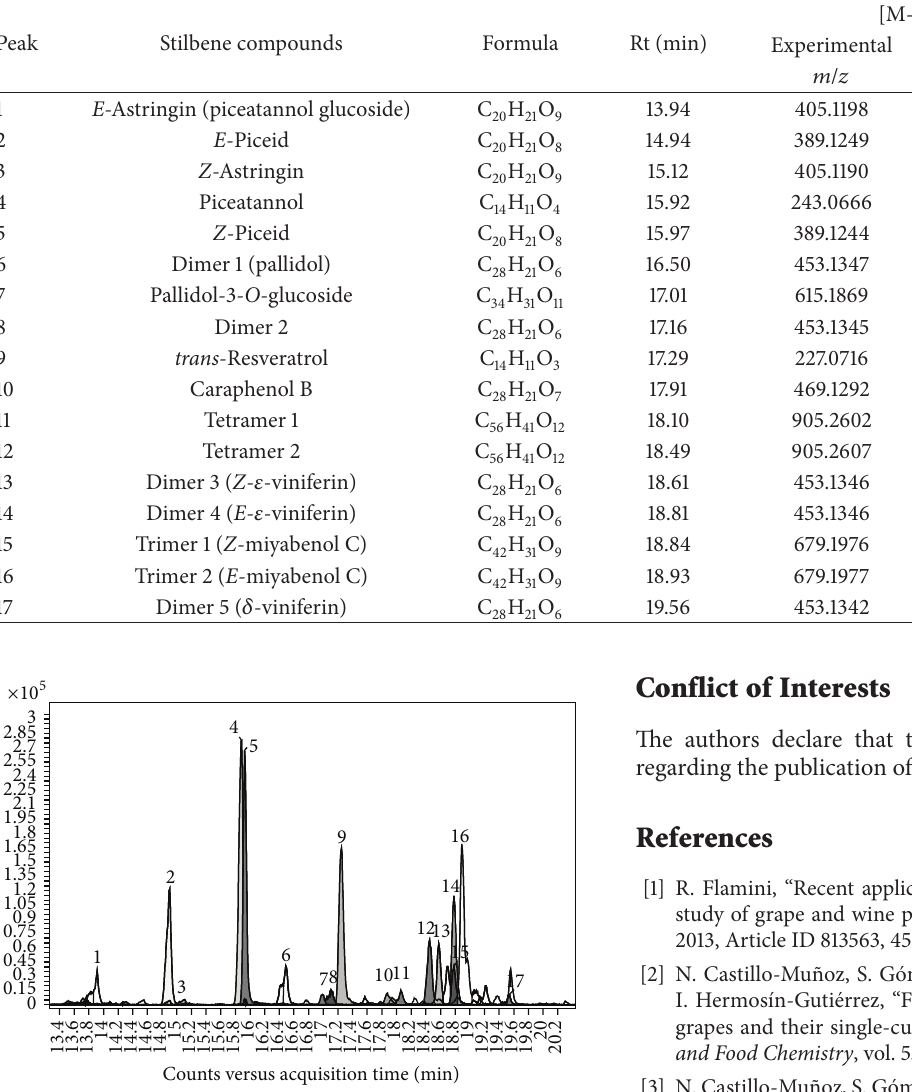
Figure 6: Extracted ion chromatograms of stilbene derivative [M- H] − ion signals identified in UHPLC/QTOF analysis of Primitivo grape